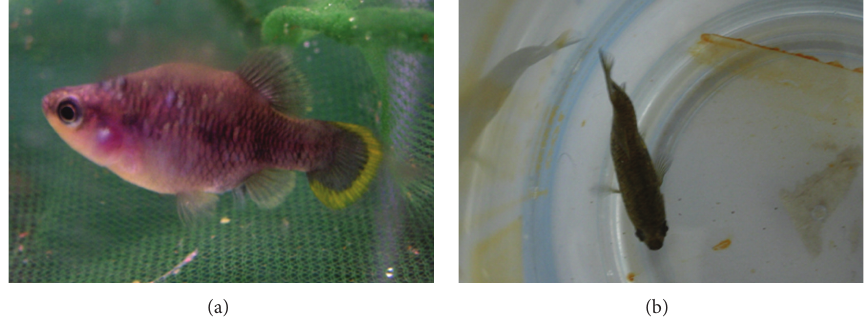
Figure 2: Lateral (a) and dorsal (b) views of an adult male showing scoliosis.